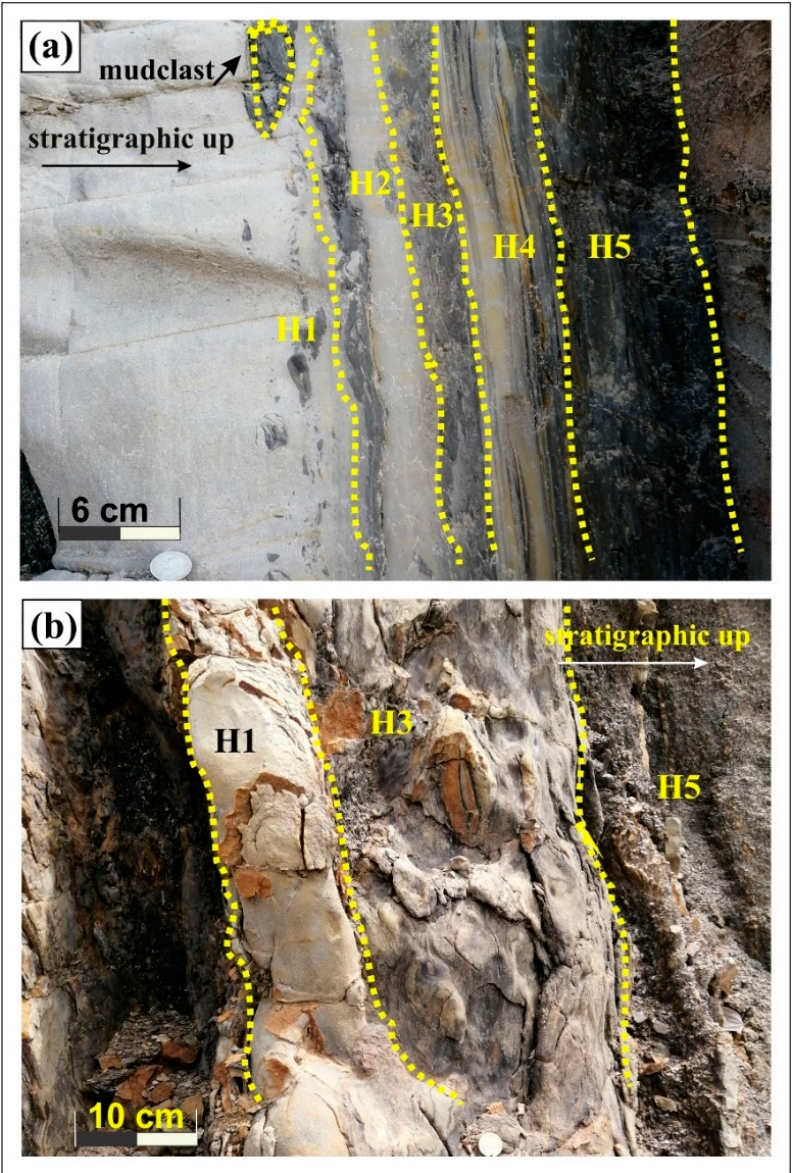
Figure 9. A brief signature of hybrid event beds in lateral lobes. ( a ) Lateral lobes have distinct brief expressions from H1 to H5 facies in the Jalan Sulaman (SUL) section, NW Sabah. ( b ) Lateral lobes predominantly contain H1 sandy hybrid intervals overlying a minor component of H3 and H5 facies, while moving from the base to the top in a stratigraphic succession exposed in the Jalan UMS (JU) section, West Sabah.